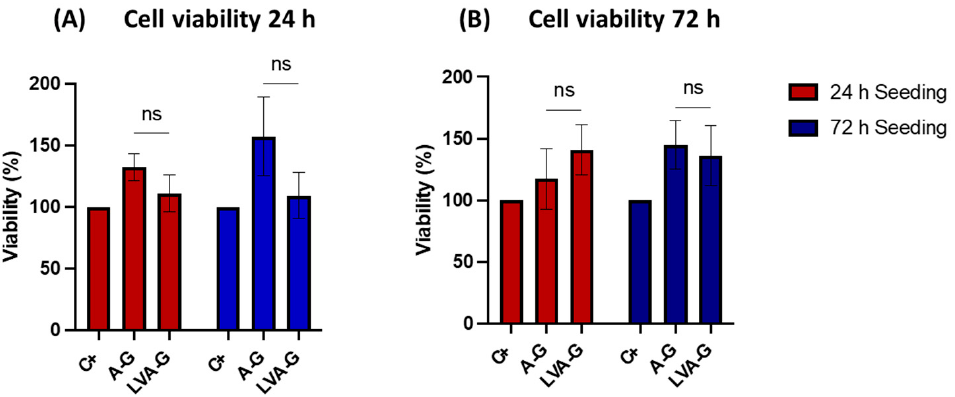
Figure 3. Cell viability of chondrocytes when in contact with the eluants from the scaffolds. The chondrocyte cells were cultured for a total of 24 h ( A ) and 72 h ( B ). No significant difference was observed between the LVA–G and A–G